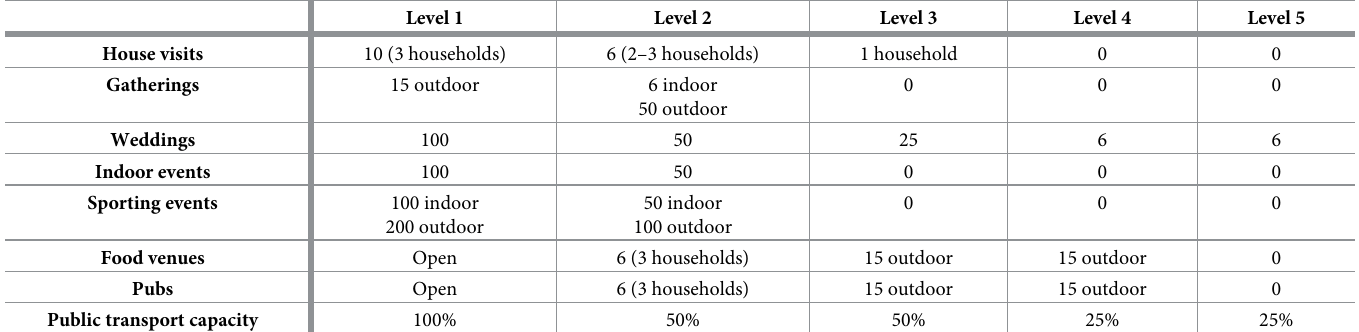
Table 1. Summary overview of the restrictions impacting on public gatherings for each of the five lockdown levels in Ireland. The numbers comprise the limits on individuals allowed to gather together in each social setting unless otherwise specified as a household limit. Details on other restrictions, such as on private travel, have been omitted for